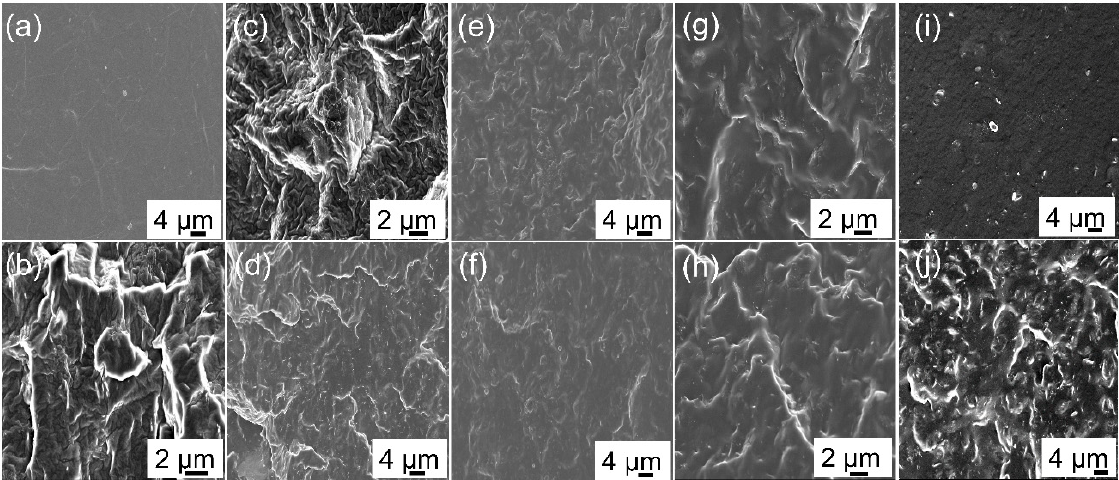
Figure 5. SEM cross-section images of TPU composites with various fillers. ( a ) Pure TPU, ( b ) 0.5 wt% MXene, ( c ) 0.4 wt% CNTs, ( d ) 0.6 wt% CNTs, ( e ) 0.4 wt% CNTs@PDA, ( f ) 0.6 wt% CNTs@PDA, ( g ) 0.25 wt% MXene/0.4 wt% CNTs, ( h ) 0.5 wt% MXene/0.6 wt% CNTs, ( i ) 0.25 wt% MXene/ 0.4 wt% CNTs@PDA, ( j ) 0.5 wt% MXene/0.6 wt% CNTs@PDA.